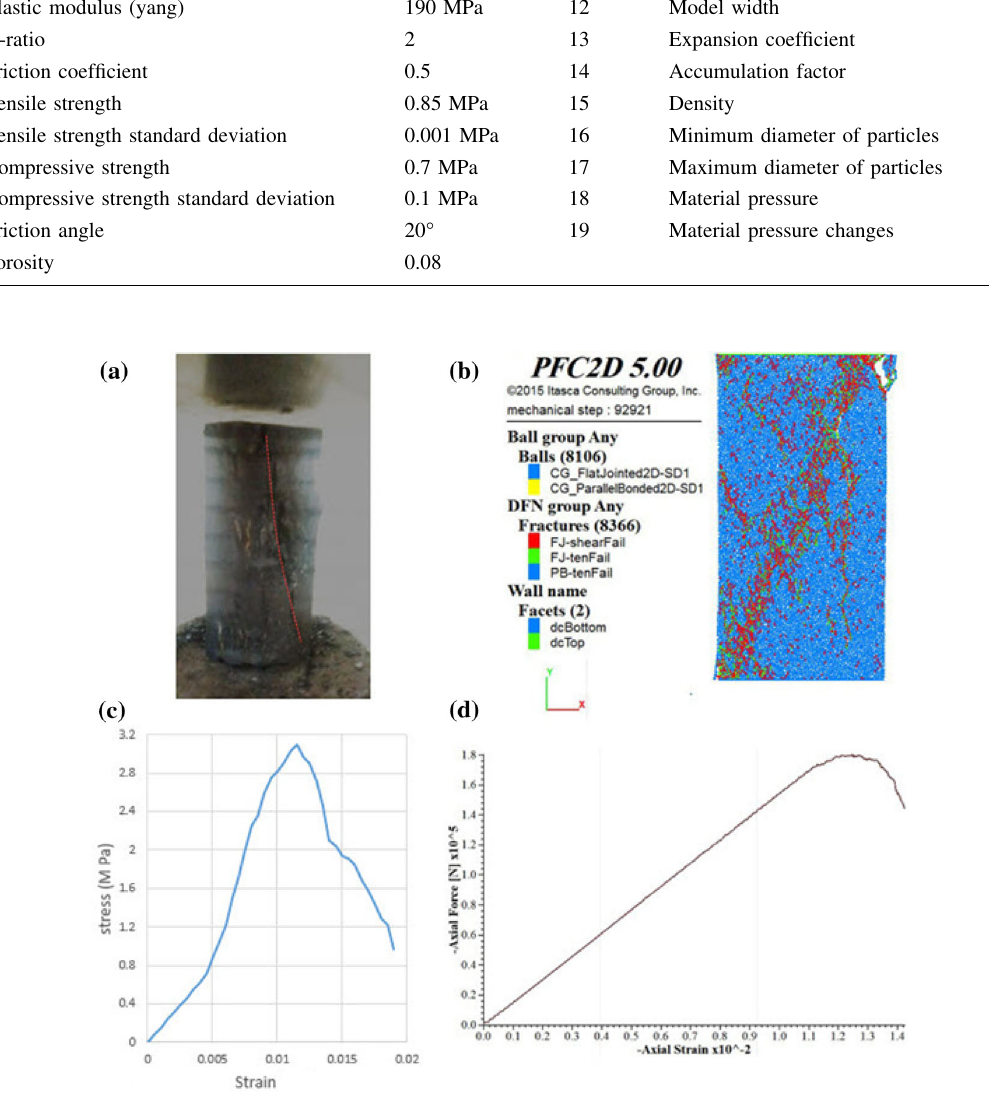
Fig. 4 Failure pattern in a experimental test, b numerical simulation, c stress–strain curve in experimental test, d stress–strain curve in numerical